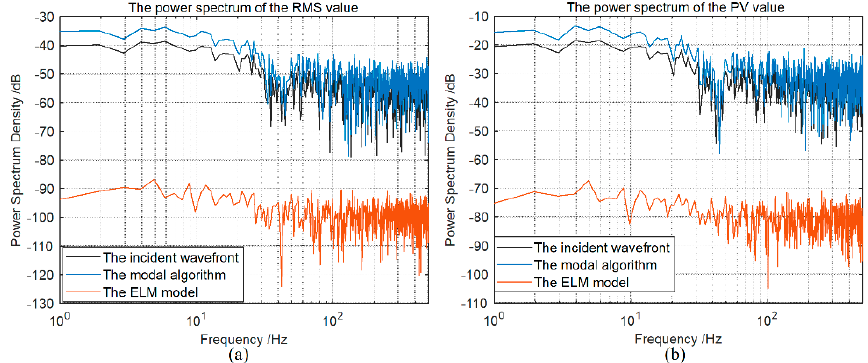
Figure 11. ( a ) The RMS power spectrum of the residual wavefront. ( b ) The PV power spectrum of the residual wavefront.